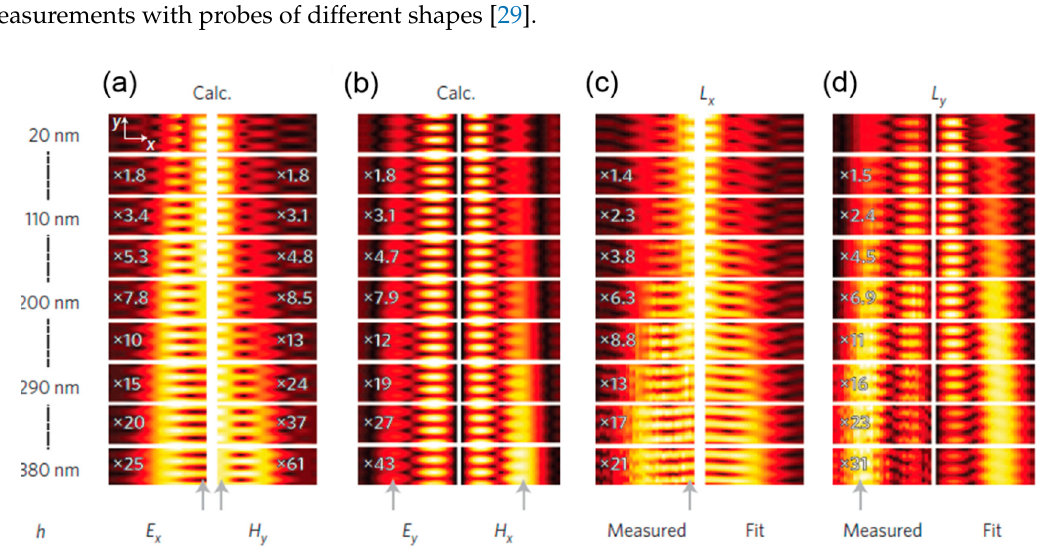
Figure 12. 3D SNOM detection of E and H fields simultaneously. ( a , b ) Calculated electric and magnetic fields in x - y planes above the PhCW surface up to a distance of 380 nm. ( c , d ) Measured 3D SNOM data (left) and data fitted to the calculated result (right). L x and L y represent two photodetectors arranged to preferentially detect E x and E y fields, respectively. Reproduced with permission from [29], Copyright Nature Photonics, 2014.